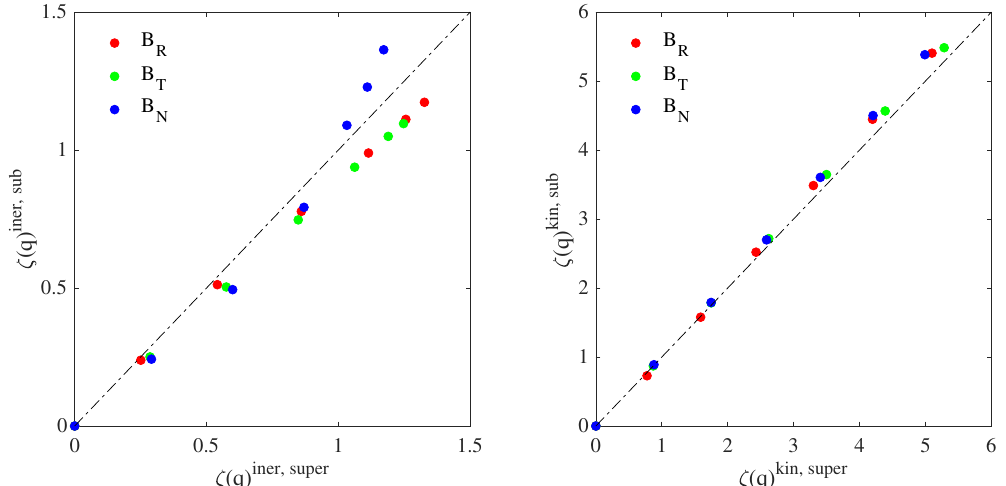
Figure 5. The scaling exponents of the sub-alfvénic solar wind vs. those of the super-alfvénic interval for each magnetic field component ( B R : red symbols, B T : green symbols, B N : blue symbols): inertial range (left panel) and sub-ion/kinetic range (right panel). The dashed–dotted lines mark the bisector of the plane where the equality ζ ( q ) sub = ζ ( q ) super